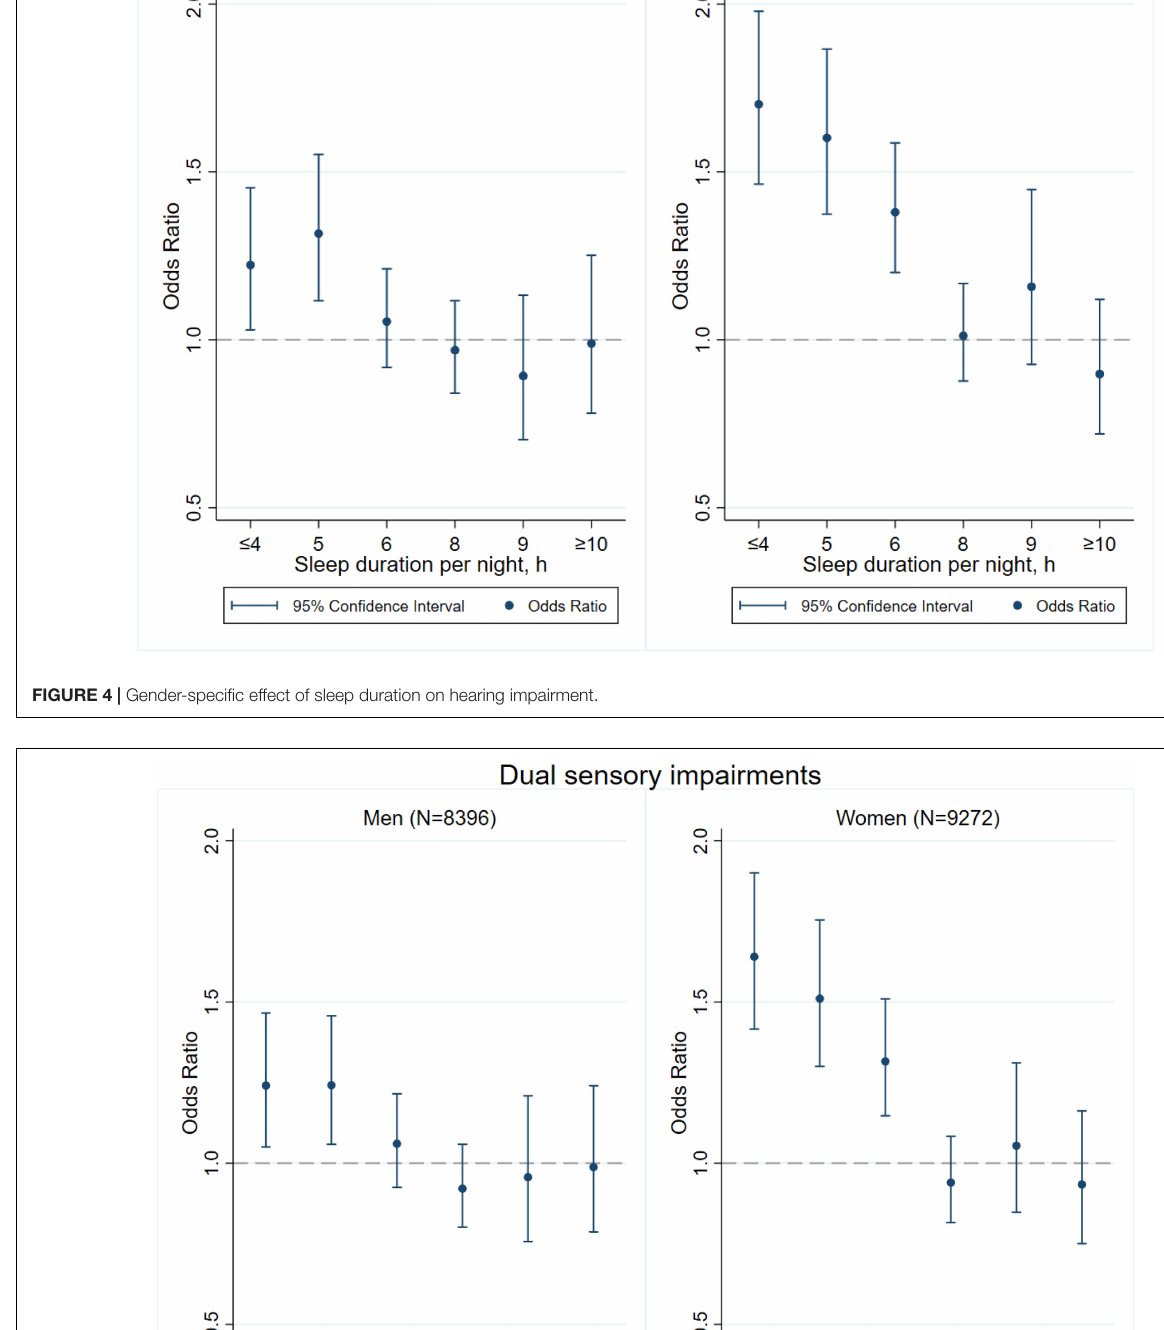
Frontiers in Aging Neuroscience |